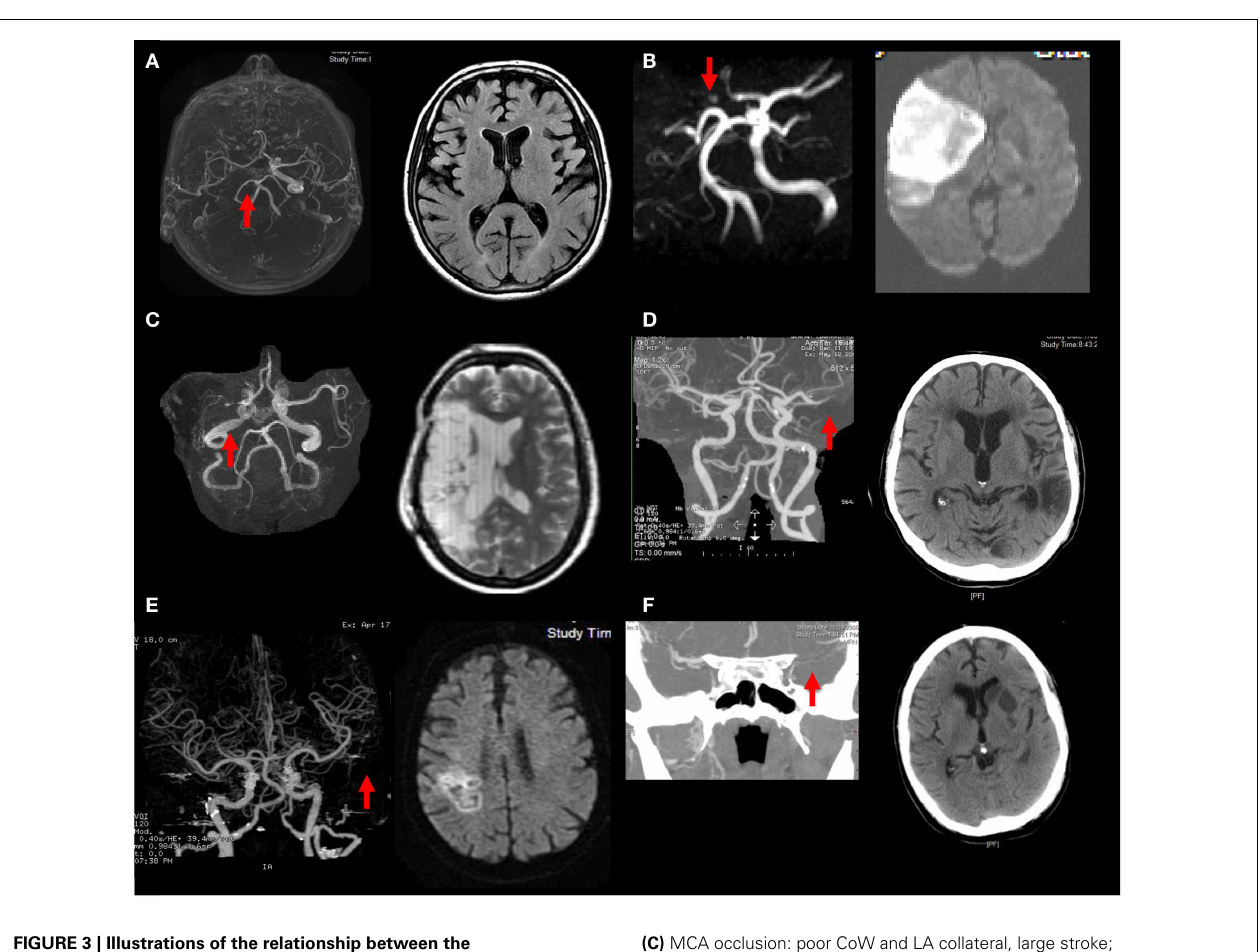
FIGURE 3 | Illustrations of the relationship between the collateral circulation and infarct size are shown . (A) ICA occlusion: good CoW and LA collateral, no infarct despite; (B) ICA and MCA occlusion: poor CoW and LA collateral, large stroke;